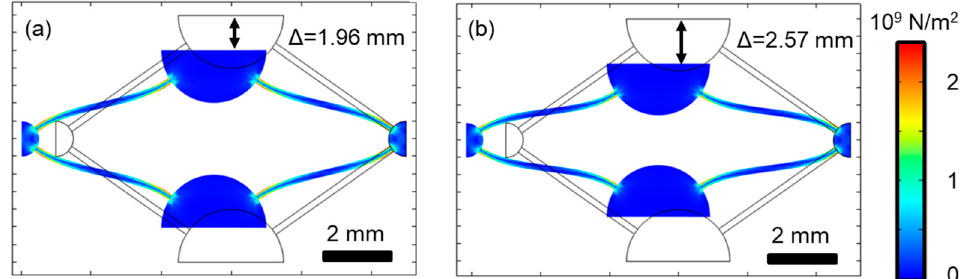
Figure 10. Deformation and resulting van Mises stresses of two unit cells with different material models subject to an identical stress (see text for more details). Material models are based on experi- mentally determined parameters for ( a ) d ≈ 180 µ m and ( b ) d ≈ 310 µ m, i.e., close to bulk properties.